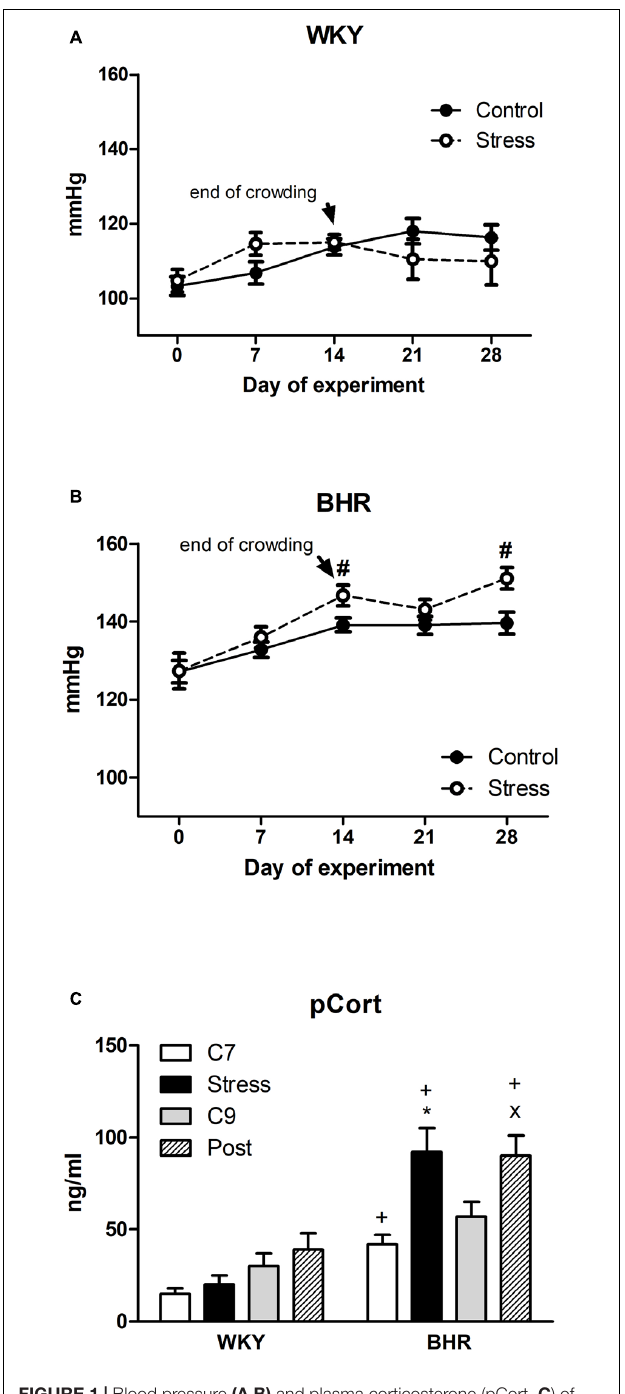
FIGURE 1 | Blood pressure (A,B) and plasma corticosterone (pCort, C ) of normotensive Wistar-Kyoto (WKY) and borderline hypertensive (BHR) rats. Controls (C7 and C9) were kept in control conditions throughout the course of experiment. Stressed rats were exposed to crowding for 2 weeks (days 1–14). After cessation of stress, one group of rats (post-stressed rats, Post) was returned to control conditions for the next 2 weeks. The results are mean ± SEM, n = 8–10/group for blood pressure, n = 6–8/group for pCort. Symbols: # p < 0.05 vs. controls of the same phenotype, ∗ p < 0.05 vs. 7-week controls (C7) of the same phenotype, x p < 0.05 vs. 9-week controls (C9) of the same phenotype, + p < 0.05 vs. the same WKY